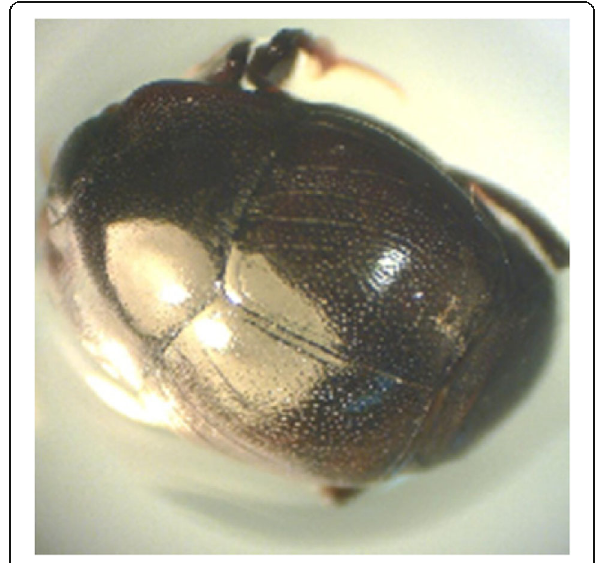
Fig. 4 The habitus of Saprinus planiusculus (Histeridae